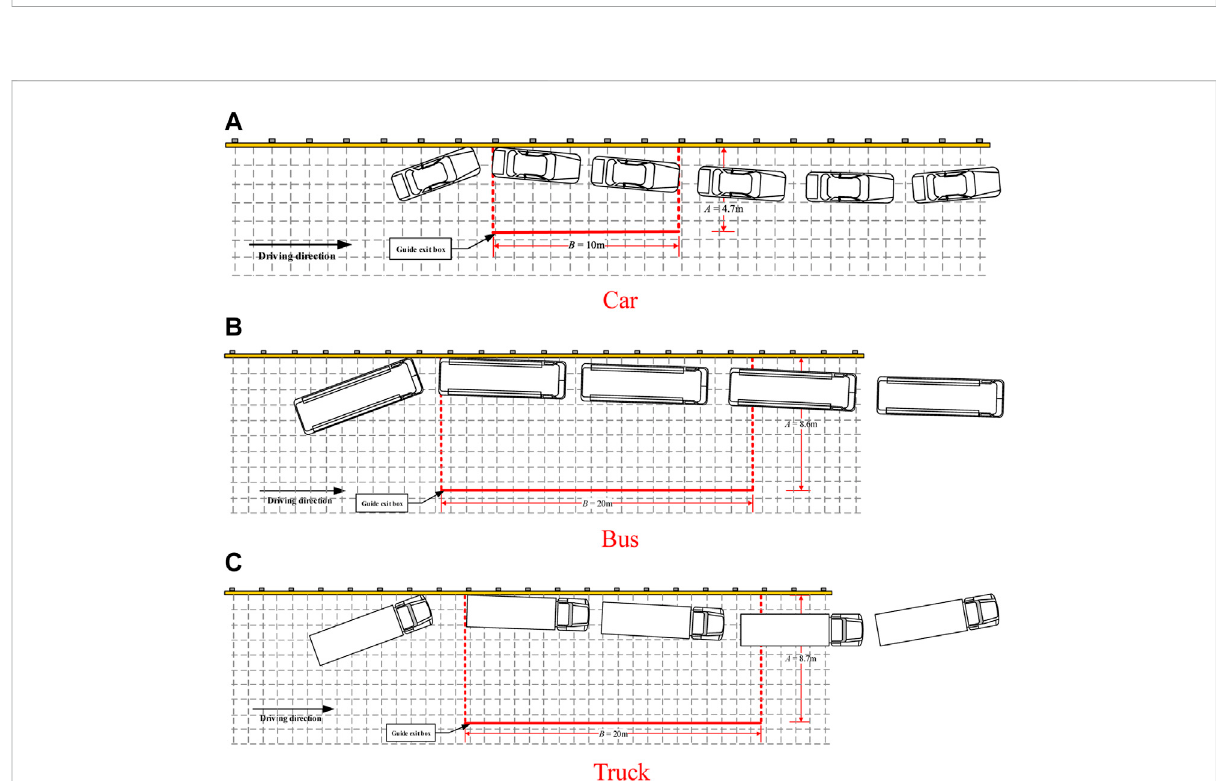
FIGURE 6 Vehicle trajectories of the car, bus, and truck (left to right). (A) Car. (B) Bus. (C)